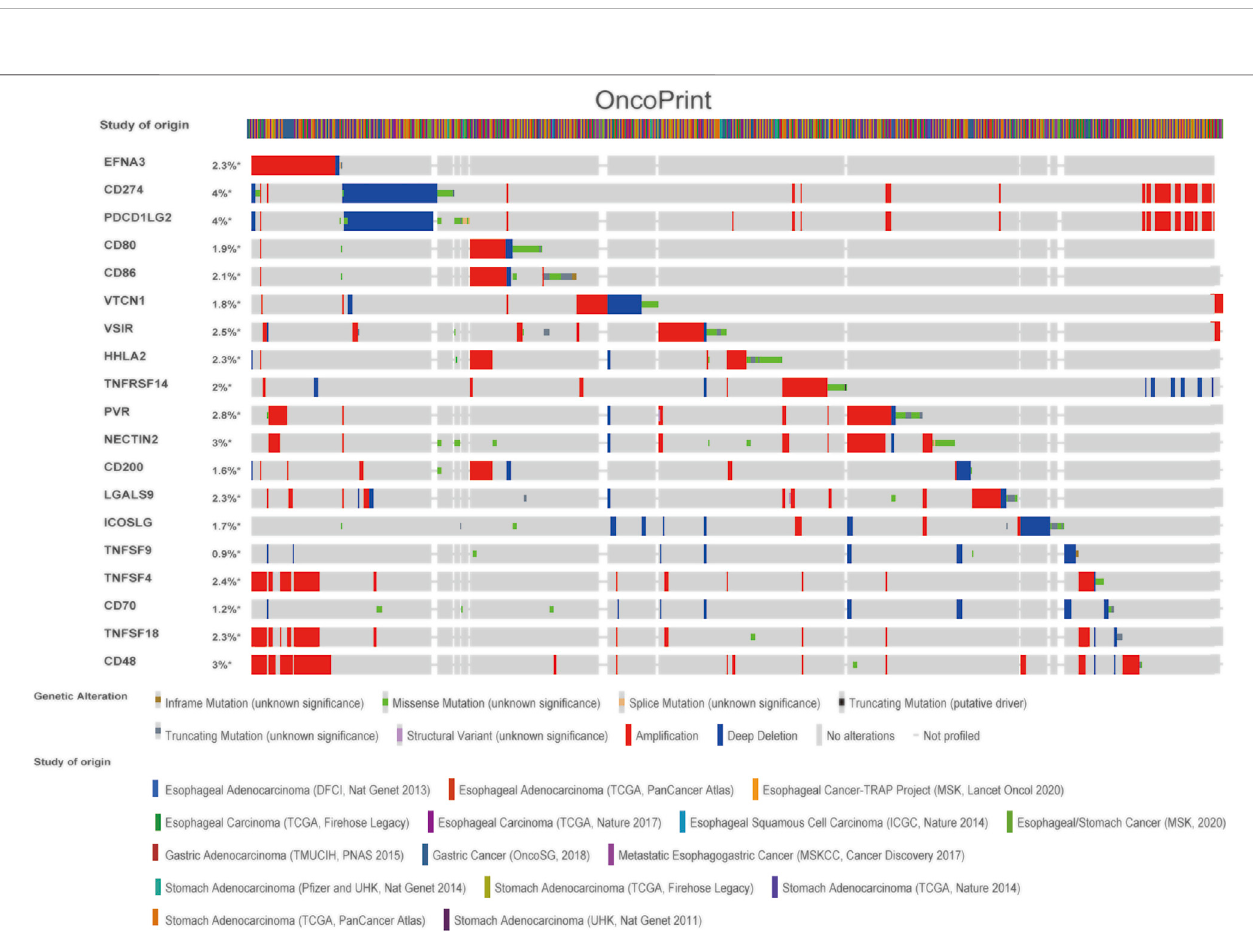
FIGURE 5 | Landscape of EFNA3 and immune checkpoint changes in GC. Compact visualization of cases with multiple genetic alterations in EFNA3 and immune checkpoints (derived from 15 studies) shown individually by cBioPortal as indicated, including fusions, ampli fi cations, deep deletions, truncating mutations, and missense